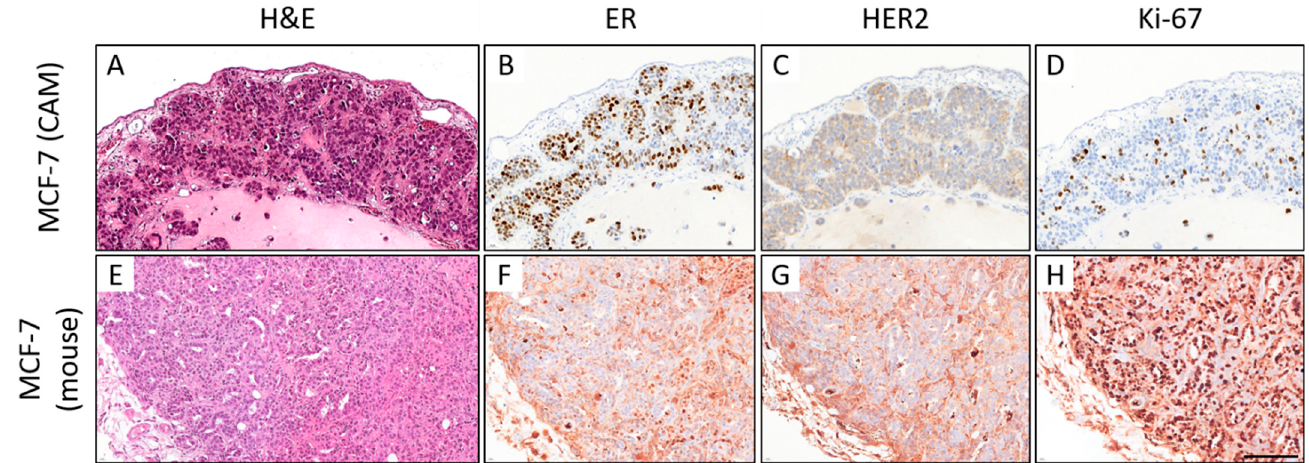
Figure 9. Comparison of the histomorphology (hematoxylin and eosin; H&E) and immunohistochemical expression of estrogen receptor (ER), HER2, and Ki-67 in MCF-7 CAM ovografts ( A – D ) vs. MCF-7 mouse xenografts (( E – H ); 400x magnification each). In the CAM ovograft, rather solid growth can be observed, whereas some tubular formations can be detected in the mouse xenograft ( A , E ). ER expression can be detected in both grafts ( B , F ). Neither the ovograft nor the mouse xenograft showed HER2 overexpression. However, the Ki-67 proliferation index was higher in the mouse xenograft, which was harvested on day 76 (CAM: ovograft harvested 5 days after engraftment). Note that there is significant nonspecific background staining in the immunohistochemical slides of the mouse xenograft, which hampers the biomarker assessment ( F – H ). This should not be confused with a specific staining of the tumor cells (for higher magnification, see Supplemental Figure S5). Scale bar: 100 µ m (applies to both cell lines and all pictures). With respect to the IHC markers AR (IRS 0/12-2/12), CK5 (mostly negative), and synaptophysin (negative), there were no significant differences between both cell lines and both in vivo models. Table 3 compares the most important immunohistochemical analyses of the MDA-MB-231 and MCF-7 CAM ovografts with MDA-MB-231/MCF-7 mouse xenografts and human hormone receptor-positive, HER2-negative and TNBC tumor tissue, showing good comparability between the in vivo models. Table 3. Comparison of MCF-7 and MDA-MB-231 CAM ovografts with MCF-7 and MDA-MB-231 mouse xenografts and human TNBC tumor tissue. The results obtained from the immunohistochemical evaluation of the in vivo CAM ovografts in comparison to tissue sections of MCF-7 and MDA-MB-231 murine xenografts and human hormone receptor-positive, HER2- negative breast cancer and TNBC FFPE samples showed that the CAM assay is a good alternative in vivo model for studying breast cancer phenotypes. Proliferation was determined as the percentage of proliferating tumor cells as assessed by Ki-67 staining. (+) indicates IHC positivity, (–) indicates IHC negativity. ER—estrogen receptor; PR—progesterone receptor; HER2—human epidermal growth factor receptor 2. MCF-7 CAM: n = 10; MDA-MB-231 CAM: n = 12; MCF-7 mouse: n = 2; MDA-MB-231 mouse: n = 4; hormone receptor-positive, HER2-negative breast cancer patients: n = 5; TNBC patients: n = 5. An histological comparing of both MCF-7 CAM and MDA-MB-231 CAM ovografts is given in Supplemental Figure S2.